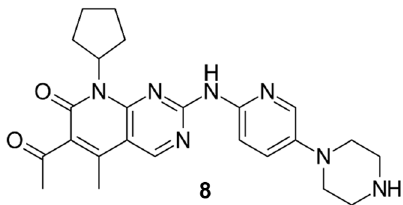
Figure 3. Structure of palbociclib ( 8 ) approved for the treatment of breast cancer.